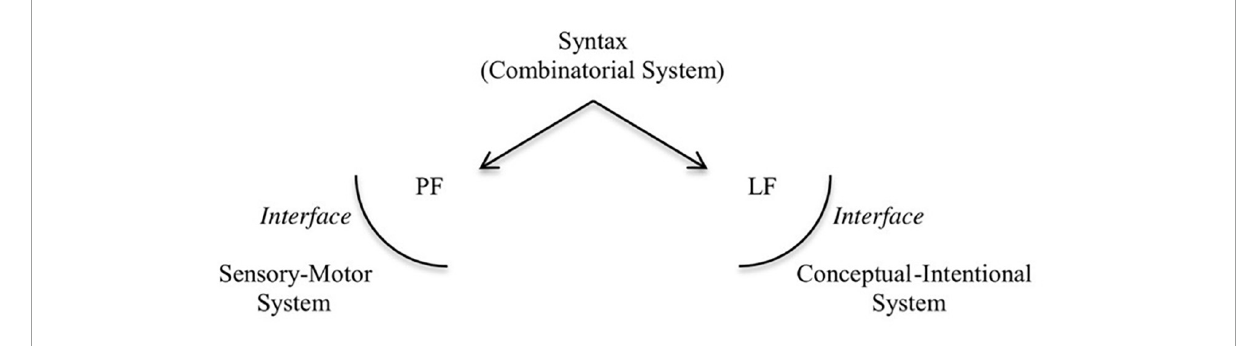
FIGURE1 The architecture of the human language faculty.